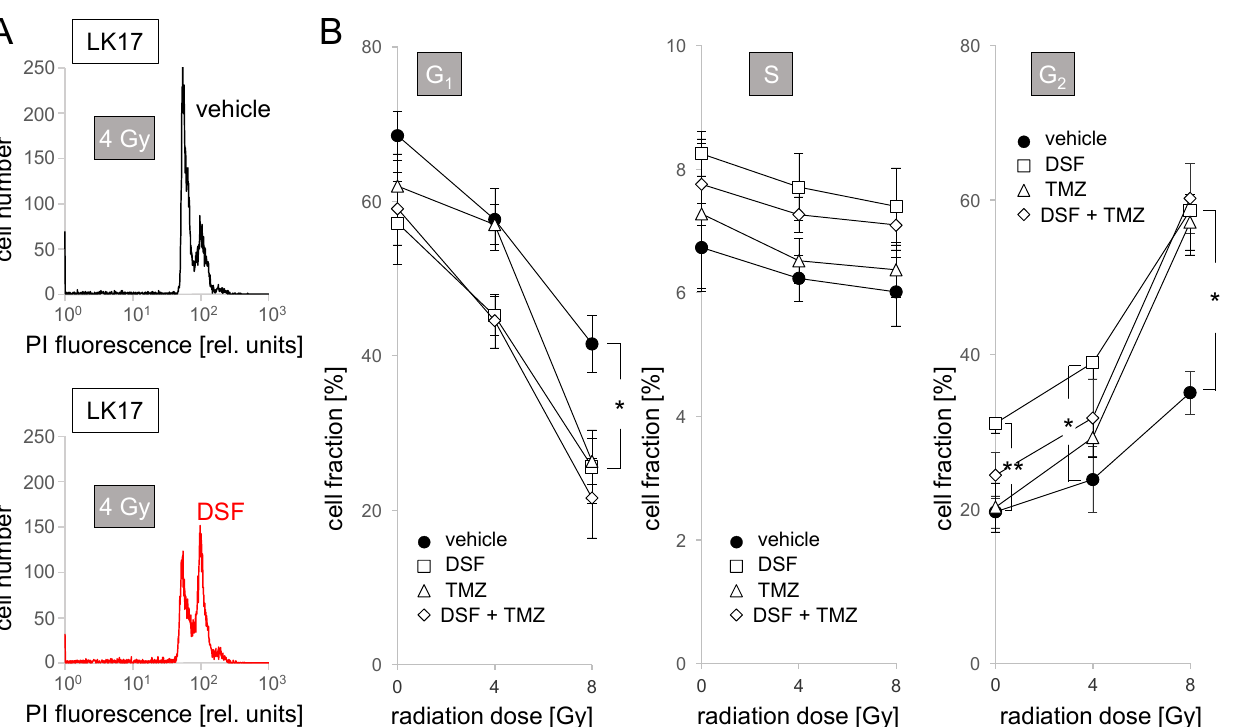
Figure 5. Disulfiram decreases G 1 and increases G 2 population in LK17 cells. ( A ) Representative flow cytometry histograms showing the distribution of the DNA-specific propidium iodide (PI) fluorescence among vehicle (black) or DSF (100 nM, red) cotreated LK17 cells 48 h after irradiation with 4 Gy. ( B ) Dependence of the mean ( ± SE, n = 6–9) percentage of cells in G 1 (left), S (middle), and G 2 (right) phase of cell cycle on radiation dose and cotreatment with vehicle (closed circles), disulfiram (DSF, 100 nM, open squares), temozolomide (TMZ, 30 µ M, open triangles) and DSF + TMZ (open diamonds). * and ** indicate p ≤ 0.05 and 0.01, respectively as calculated by Kruskal–Wallis nonparametric ANOVA and Dunn’s multiple comparisons